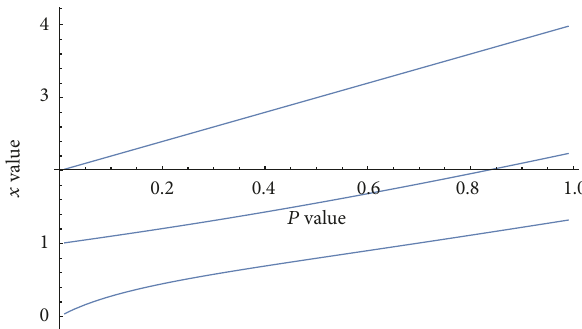
Figure 6: The curves 𝑥 ∗ (𝑖) at threshold. From bottom to top: 𝑥 ∗ (4) , 𝑥 ∗ (3) , and 𝑥 ∗ (2)